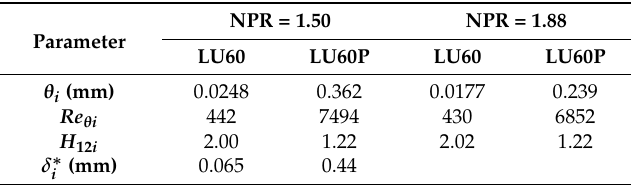
Table 2. Effect of nozzle exit short parallel extension.